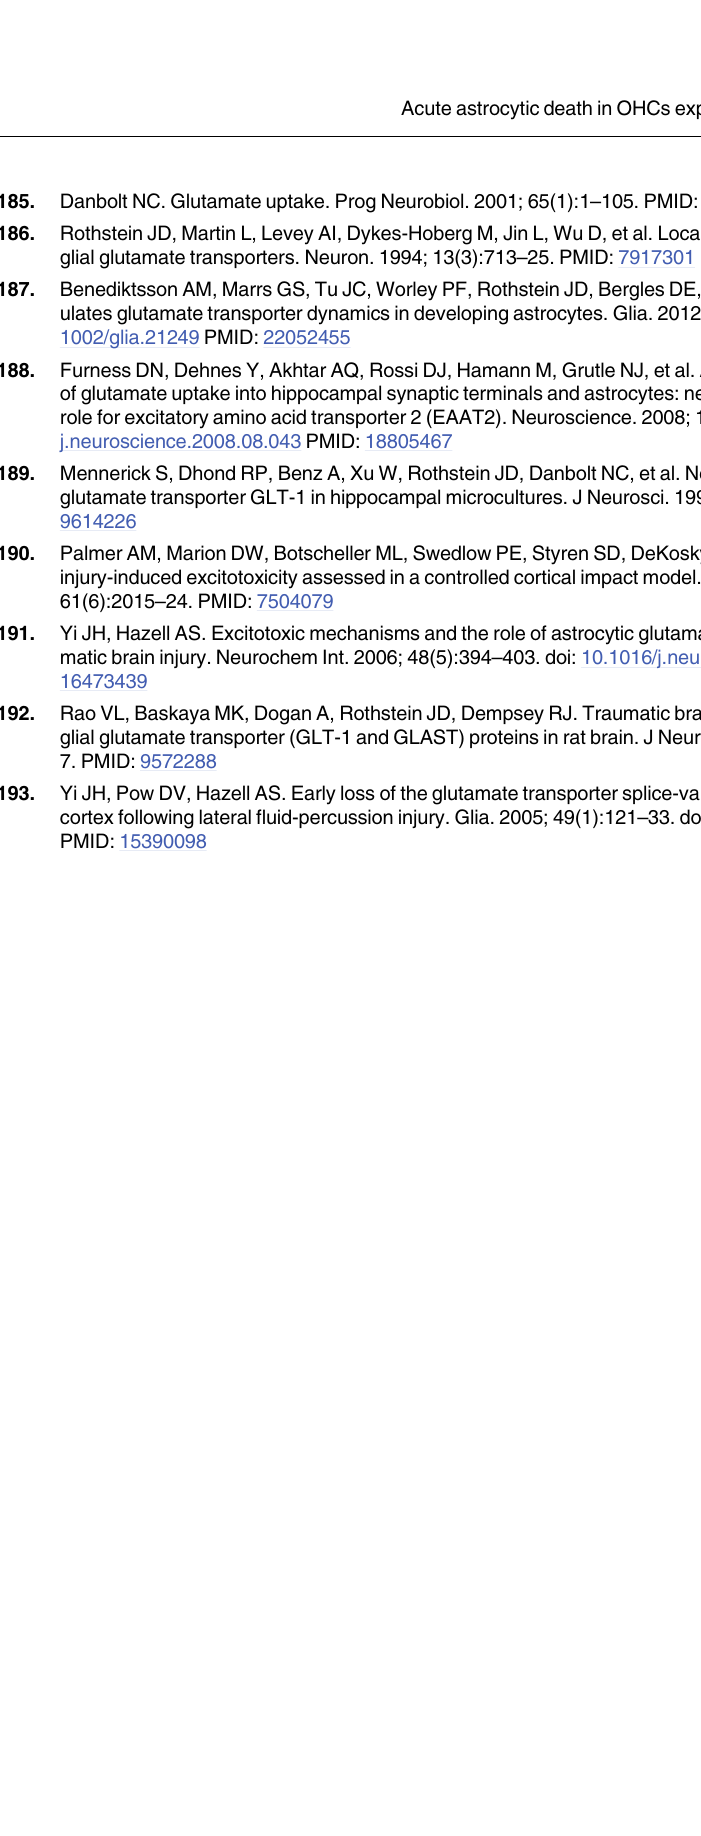
PLOS ONE | DOI:10.1371/journal.pone.0173167 March 6,